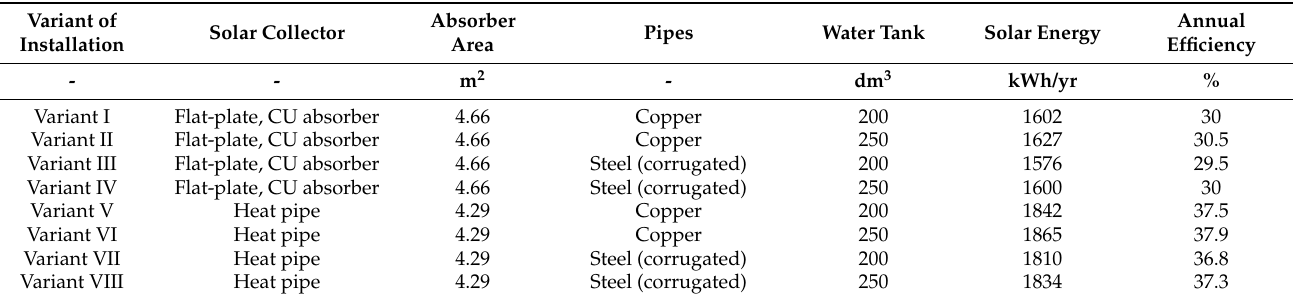
Table 1. Technical parameters of the analyzed system